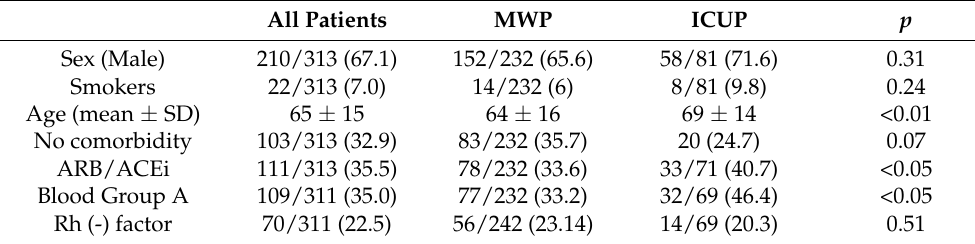
Table 1. Demographic and clinical data of enrolled patients and comparison between groups. All